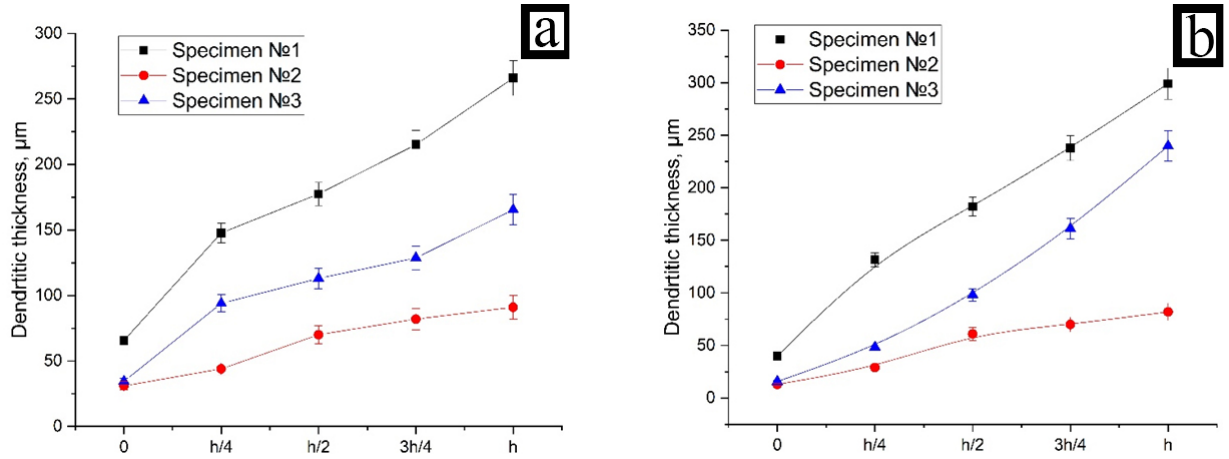
Figure 8. Distributions of dendritic thickness values in height: ( a ) in the central part; ( b ) in the extreme lateral part.